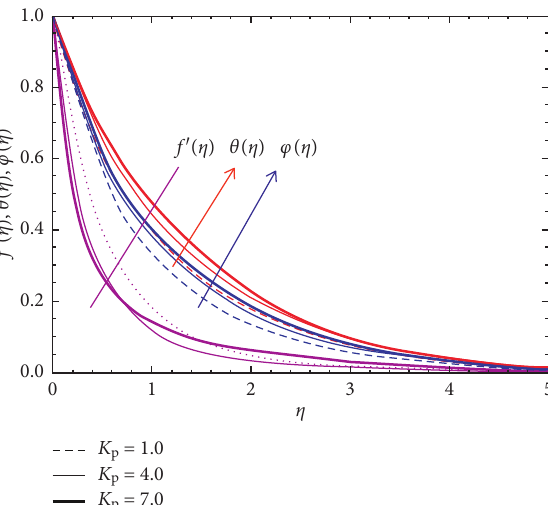
Figure 6: Impacts of porosity parameter K temperature, and concentration profiles.